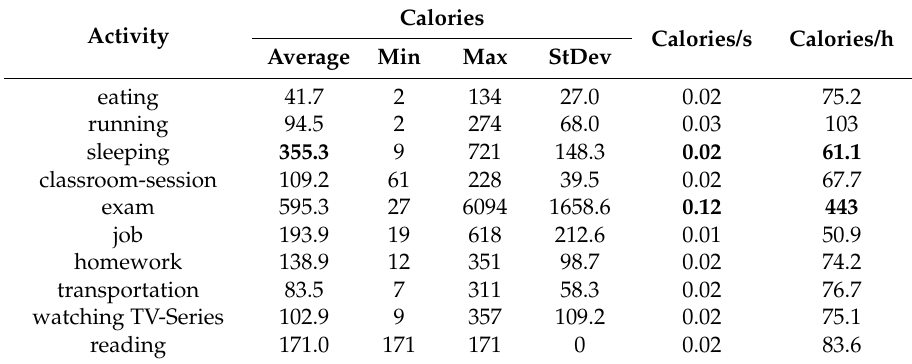
Table 4. Calories by